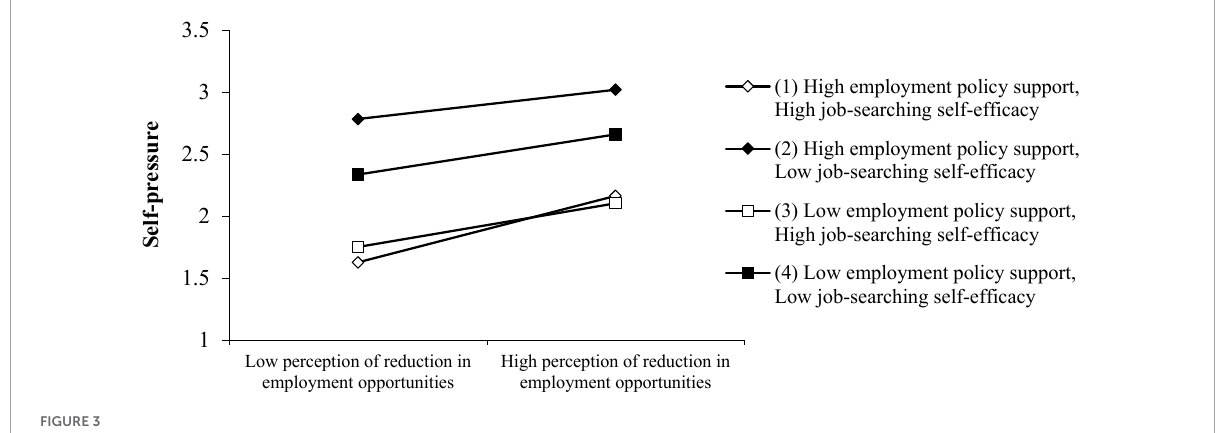
FIGURE3 The joint-moderating effect of employment policy support and job-searching self-efficacy on the perception reduction of employment opportunities and employment pressure of college students.